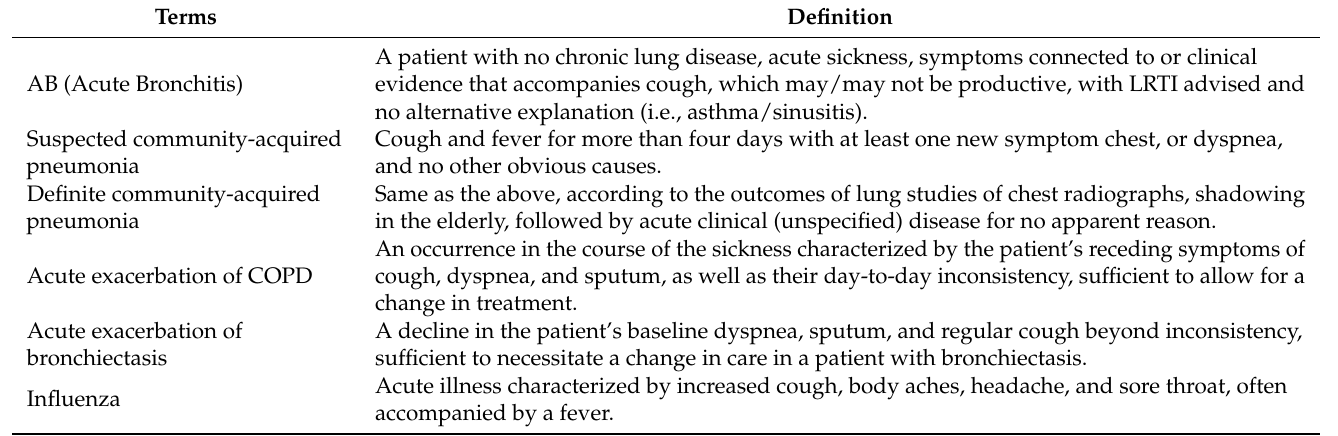
Table 1. Definition related to